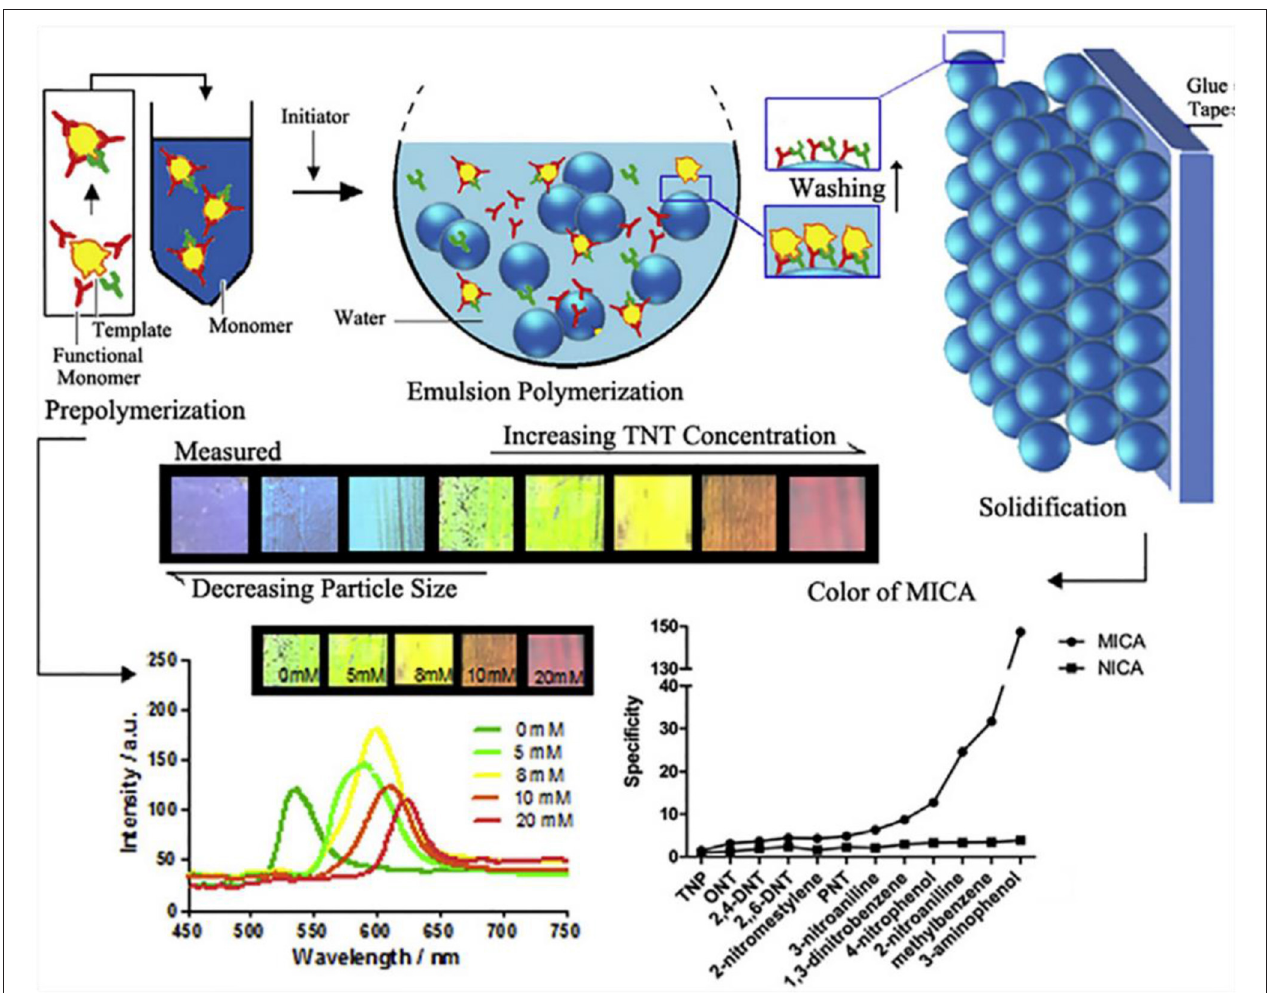
FIGURE 4 | The fabrication of the molecularly imprinted colloidal array and the visual detection of 2,4,6-trinitrotoluene (reprinted with the permission of Lu et al., 2016; Copyright 2016 Elsevier).